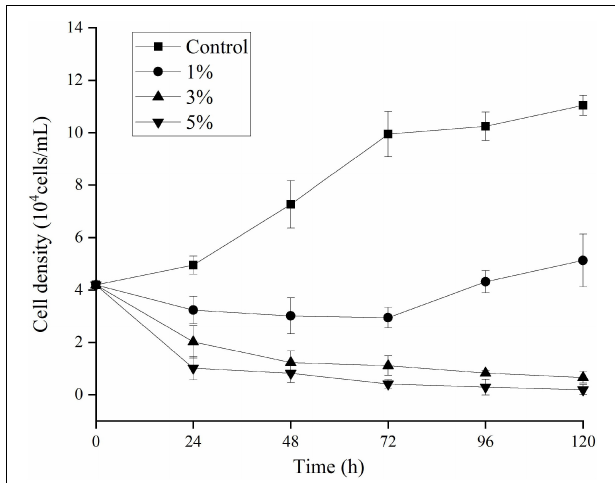
FIGURE 1 | Algicidal activity levels using different doses of Paracoccus homiensis O-4 against Karenia mikimotoi . Error bars represent the standard deviation of the triplicates.